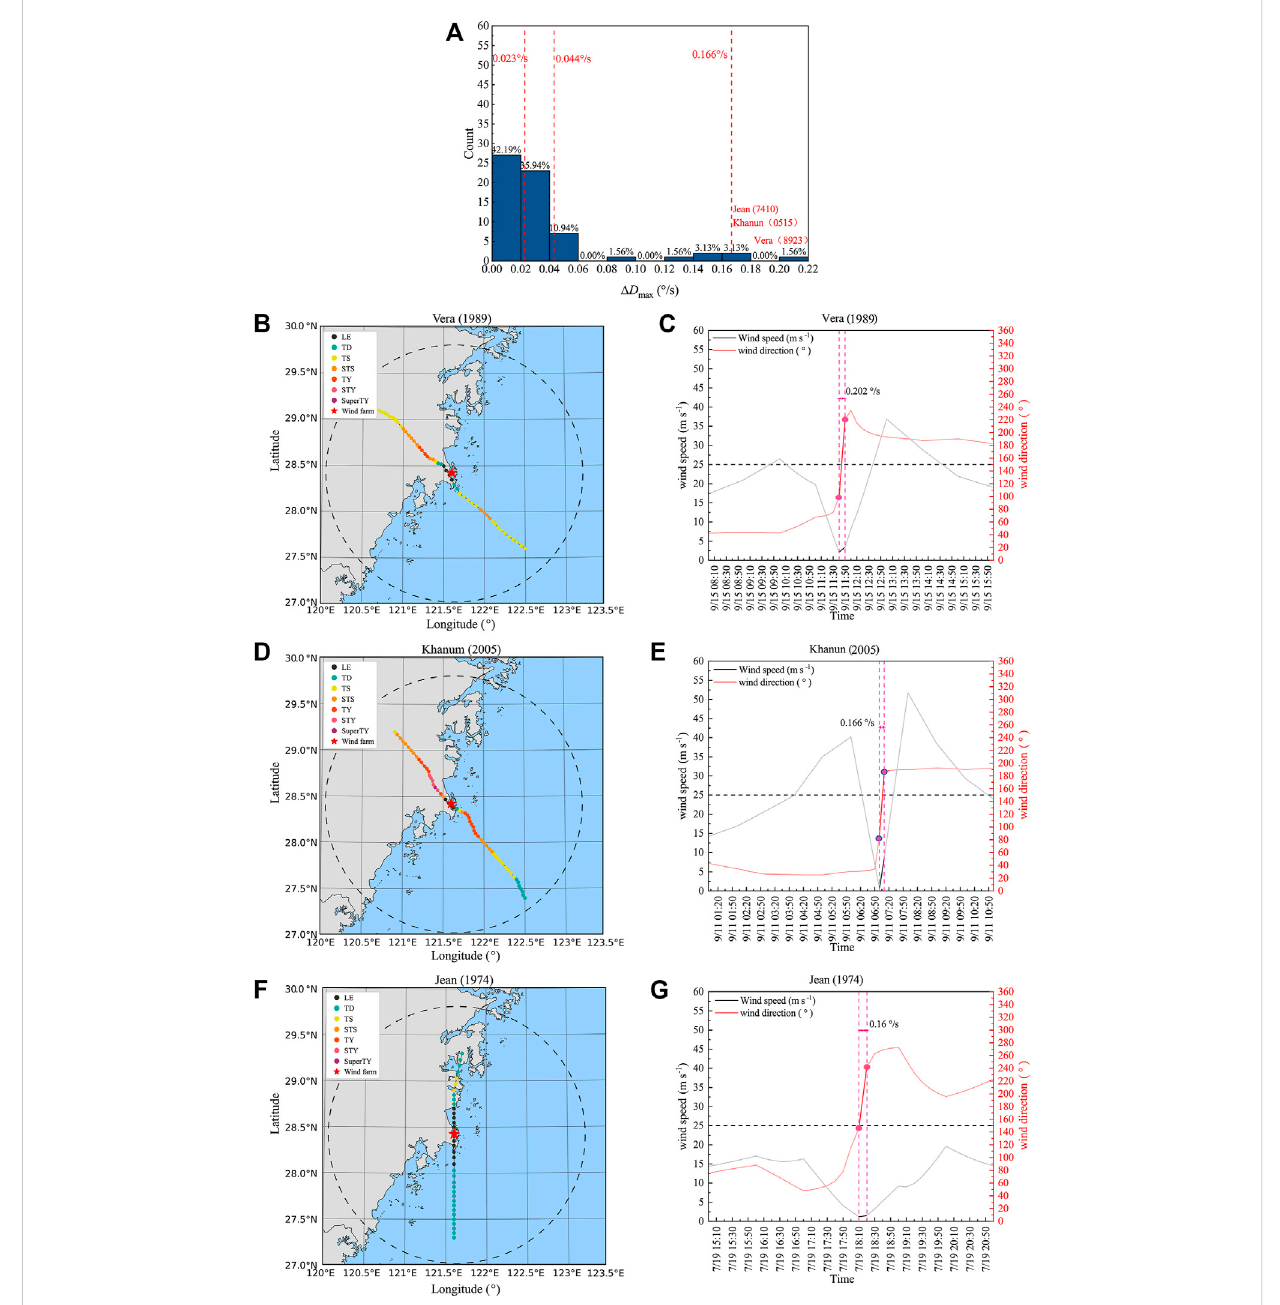
FIGURE 10 (A) Frequency distribution of themaximum rate ofchange in wind direction at hubheightunder thein fl uenceof tropical cyclones ( Δ D F) thebest-trackpositions/intensities,and (C,EandG) temporalvariationsinwindspeedandwinddirectionfortropicalcyclones (DandC) Vera(1989), (D and E) Khanum (2005), and (F and G) Jean (1974). Orange dashed lines are the threshold cutoffs of 0.023 ° , 0.044 ° , and 0.166 ° s − 1 , black dashed circle represents thestudy area withradius of150 kmcenteredonthewind farm, and pink dashedlines in (C,Eand G) denotetheperiod ofmaximumrate of change in wind direction angle associated with the tropical